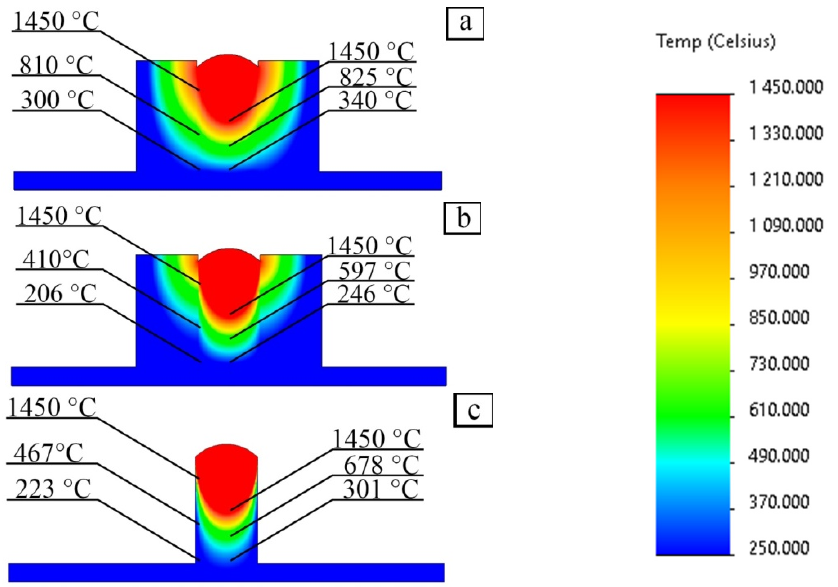
Figure 3. Results of simulation of the process of thermal pattern formation of AISI 308LSi steel work- pieces obtained by multilayer build-up welding. Temperature values are given in ◦ C. ( a ) specimen № 1; ( b ) specimen № 2, ( c ) specimen № 3.